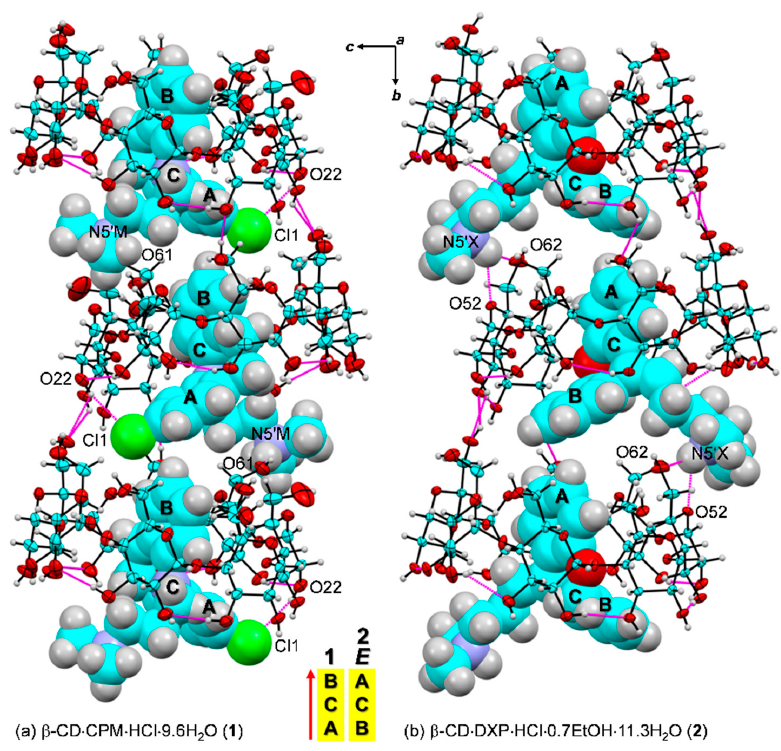
Figure 5. Intermolecular N/O − H ∙∙∙ O/Cl hydrogen bonds stabilizing the inclusion complexes ( a ) β -CD − CPM HCl ( 1 ) and ( b ) β -CD − DXP HCl ( 2 ); see magenta lines. The crystal lattice is also stabilized by intermolecular edge-to-face π∙∙ π interactions between the A- and the B-rings of 2 1 -symmetry related guest molecules along the b -axis. The ORTEP diagrams are shown with 30% probability level. For 2, E -DXP (occupancy factor 0.63) is shown. Solvent molecules and chloride ions are omitted for clarity. The different inclusion structures from the varied alignments of the A-C-B-rings of CPM and DXP are emphasized in the middle.